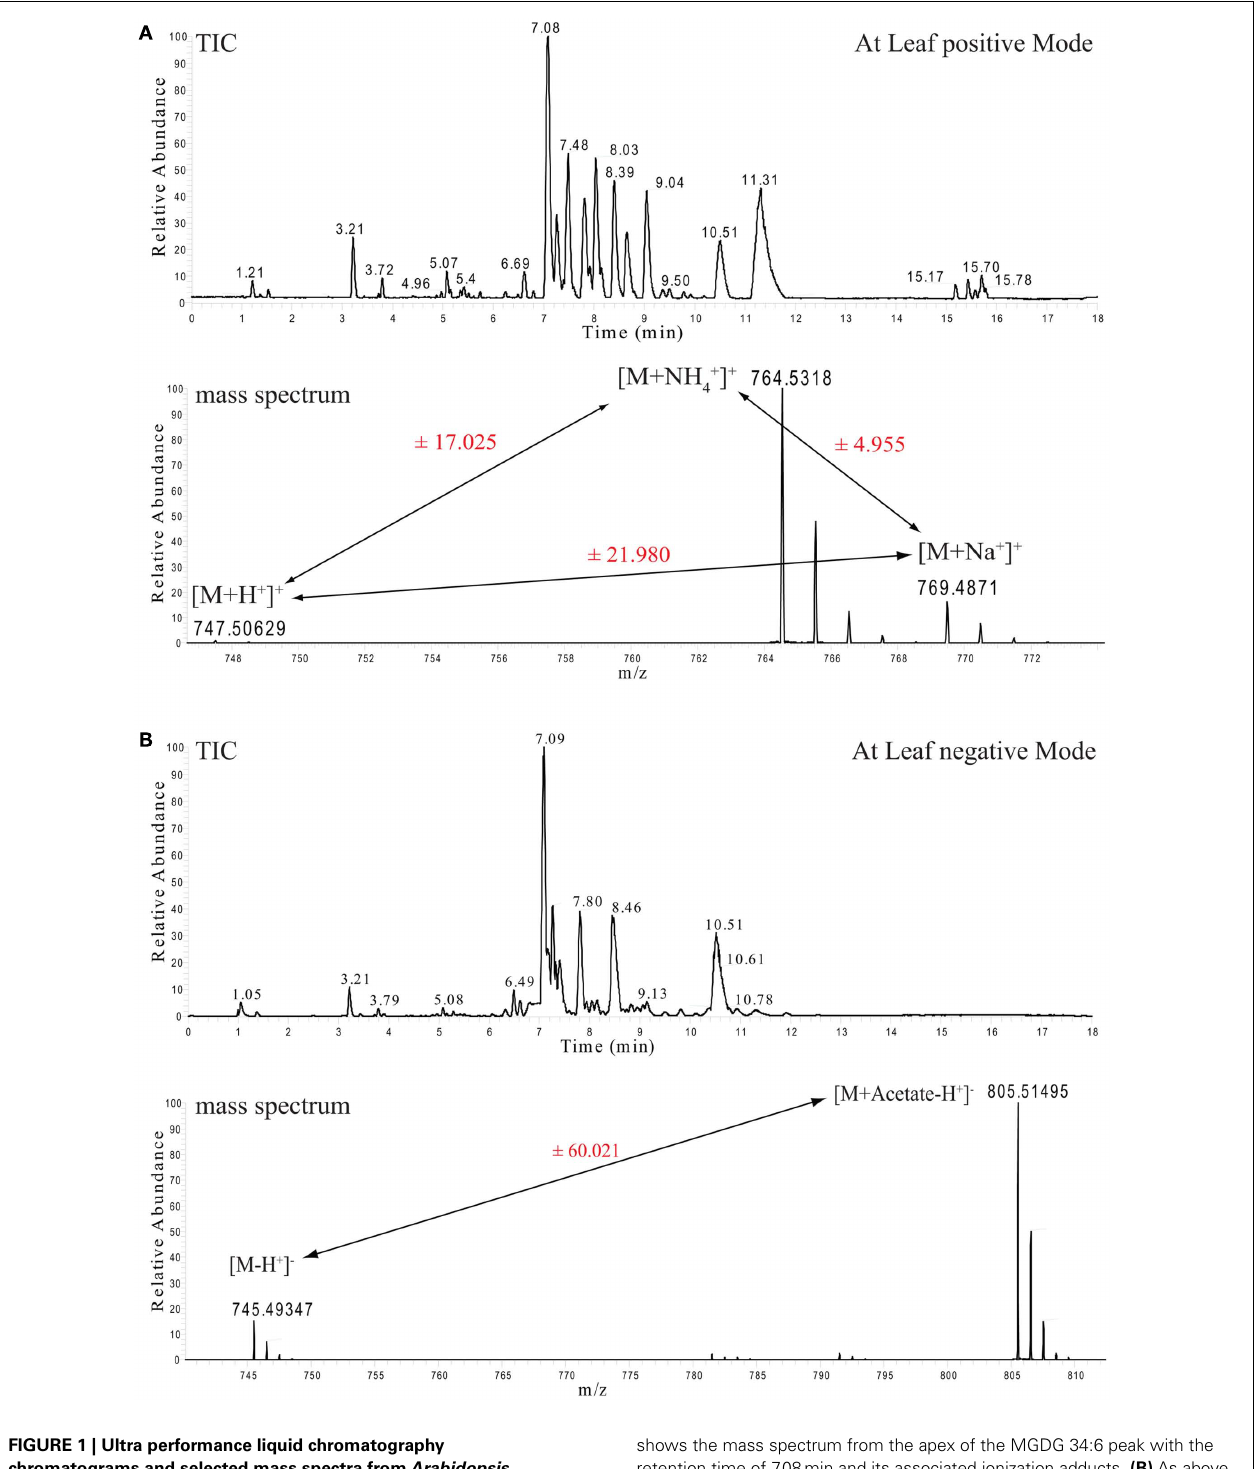
FIGURE 1 | Ultra performance liquid chromatography chromatograms and selected mass spectra from Arabidopsis thaliana leaf lipid extracts. (A) Total ion chromatogram (TIC, upper part) of mass spectra recorded in positive ion mode.The lower part